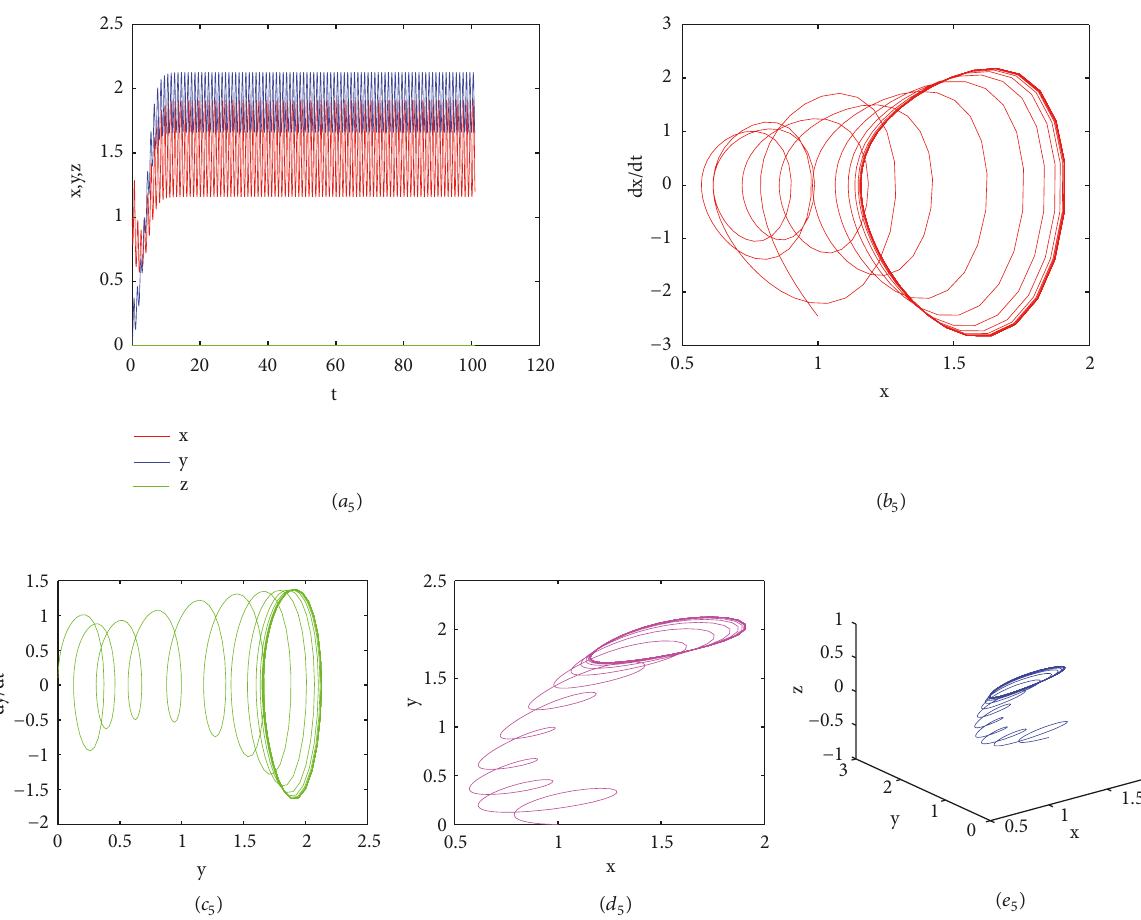
Figure 14: The results of Experiment 6: (𝑎 5 ) time series plot of 𝑥, 𝑦,𝑧 ; (𝑏 5 ) phase diagram of 𝑥 ; (𝑐 5 ) phase diagram of 𝑦 ; (𝑑 5 ) projected on the (𝑥,𝑦) -plane; (𝑒 ) on the three-dimensional space. 5